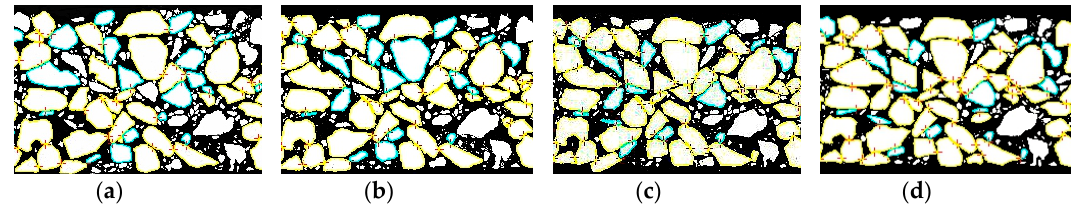
Figure 6. Gradual change in mesoscopic contact characteristics of SMA-13 main skeleton. ( a ) Before